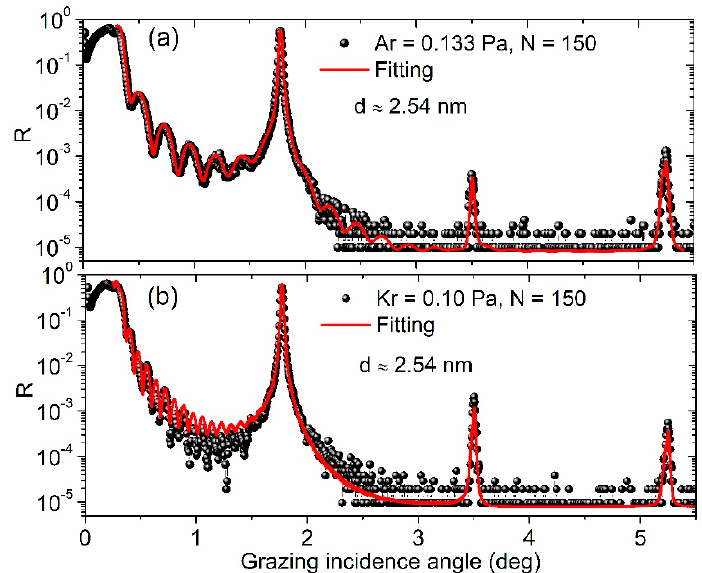
Figure 3. GIXR measurements and fitted results of the Ar-made ( a ) and Kr-made ( b ) multilayers with 150